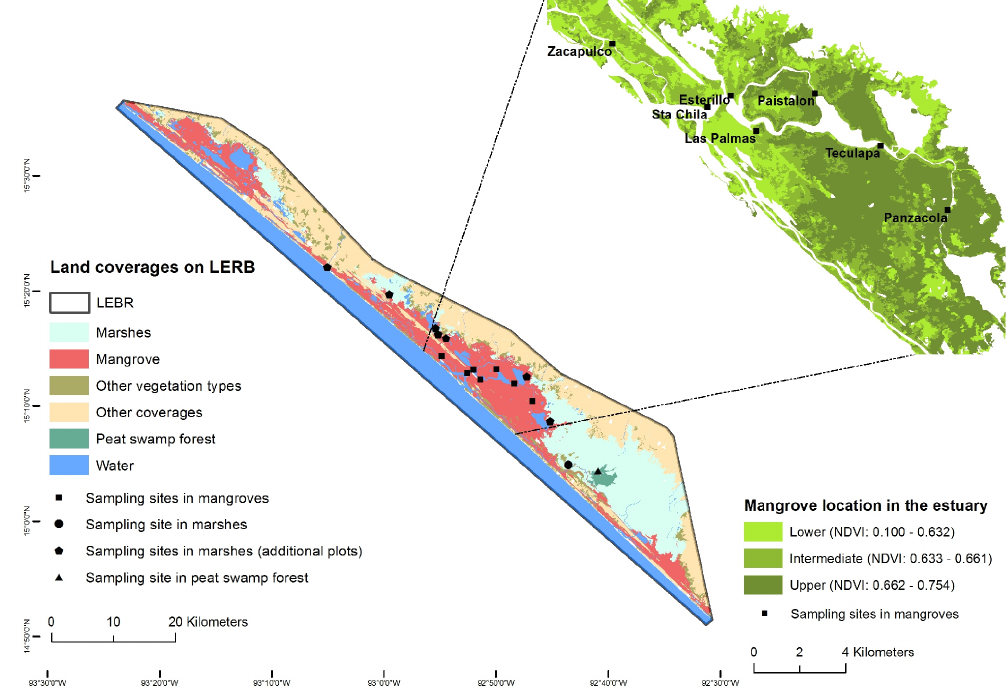
Figure 1. Mangrove, peat swamp and marsh sampling sites within La Encrucijada Biosphere Reserve, Mexico. Mangroves were classified according to the NDVI (see Sect. 2.2) into three classes, which broadly corresponded to a range of mangroves from the upper to the lower